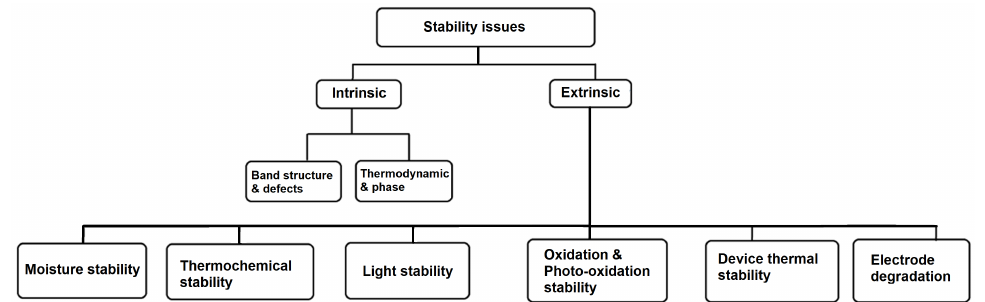
Figure 13. A pictorial depiction of the stability issues in perovskite solar